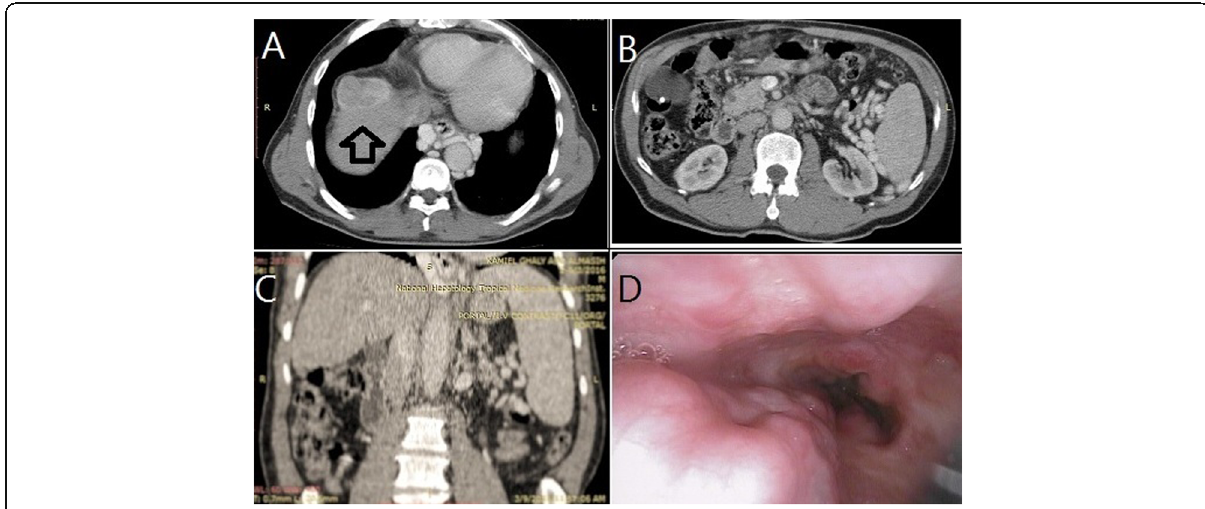
Fig. 5 a – d A 60-year-old male patient. a CT axial image of a triphasic CT study of the liver with CT portography showing esophgeal varices